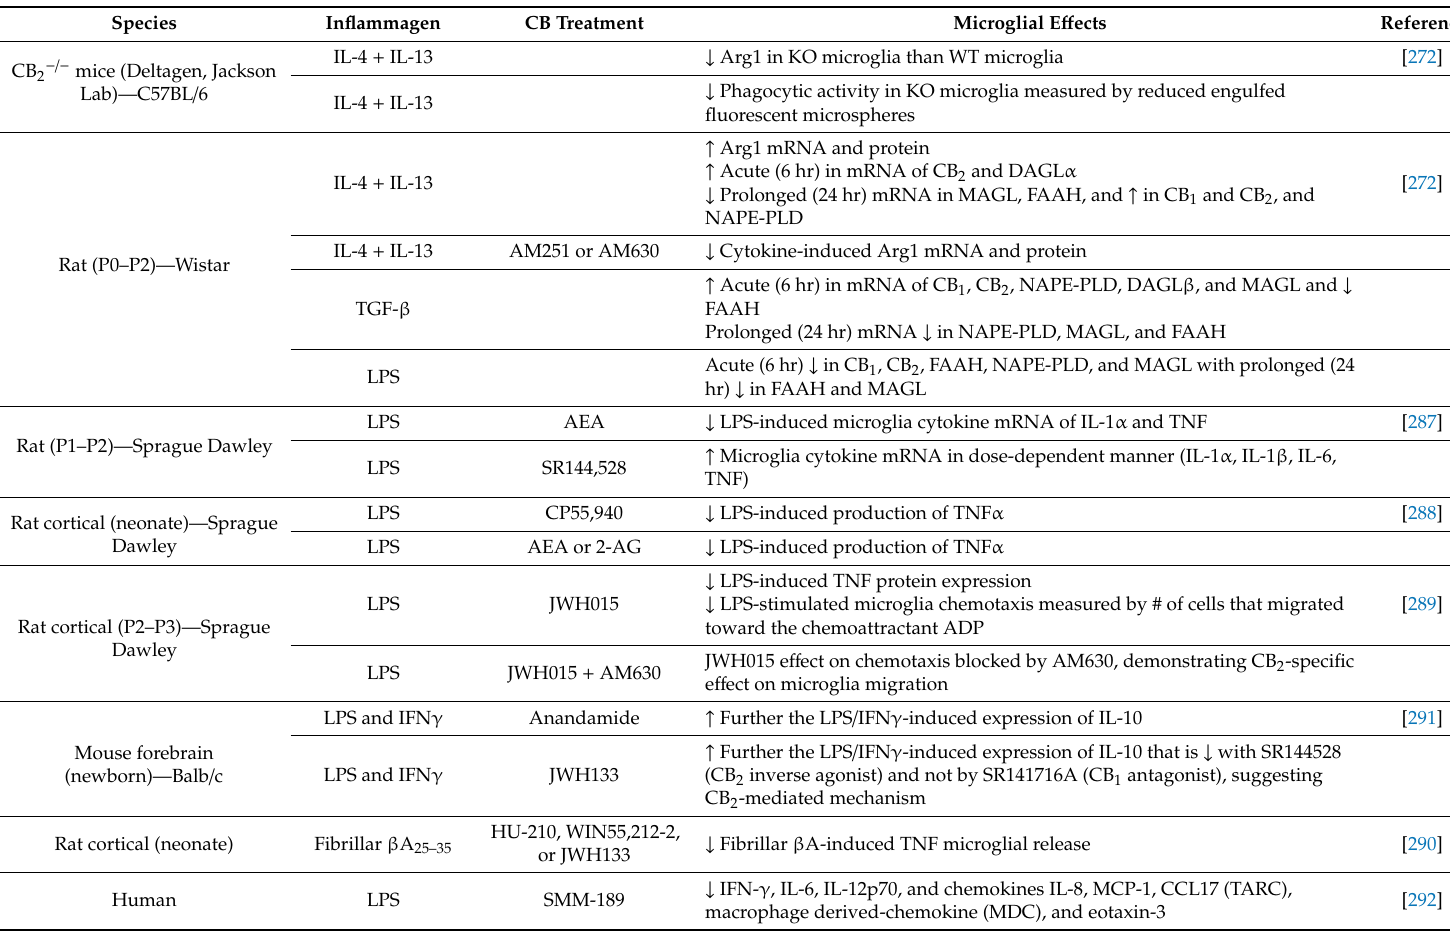
Table 1. Cannabinoid-mediated e ff ects on immune cell function of primary microglial cell cultures. ↑ , increase. ↓ , decrease. LPS, lipopolysaccharide. CB 1 / 2 non-selective agonist: CP55, 940, WIN55,212-2, HU-210. CB 1 antagonist: AM251. CB 2 selective agonist: JWH133, JWH015. CB 2 selective antagonist: AM630. CB 2 inverse agonist: SMM-189,